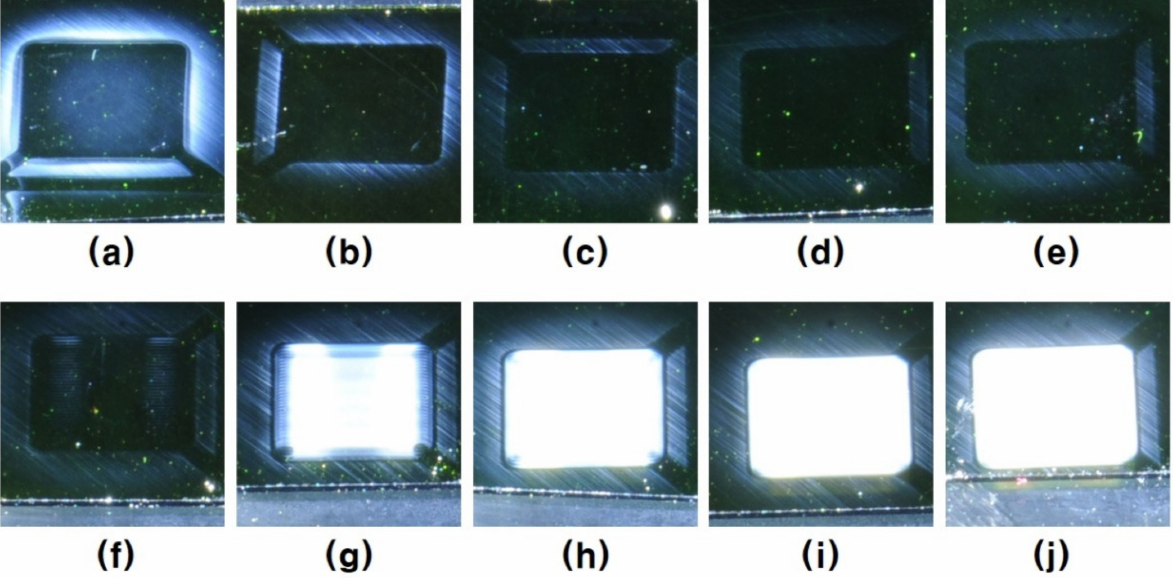
Figure 7. Specimen surface of 6 mm by 6 mm square area raster scan etch by the mixed gas filament plasma of He-NF 3 and O 2 . ( a – e ) NF 3 1 sccm, ( f – j ) NF 3 2 sccm, ( a , f ) O 2 0 sccm, ( b , g ) O 2 1 sccm, ( c , h ) O 2 2 sccm, ( d , i ) O 2 3 sccm, ( e , j ) O 2 4